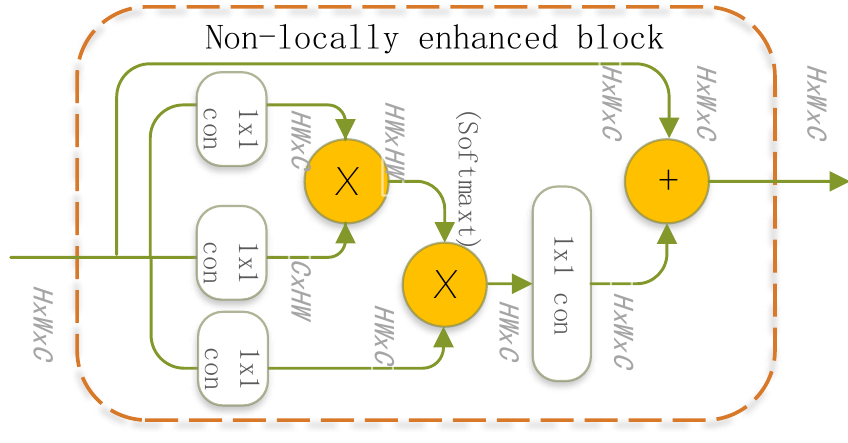
Figure 4. Calculation of non-locally enhanced operation.